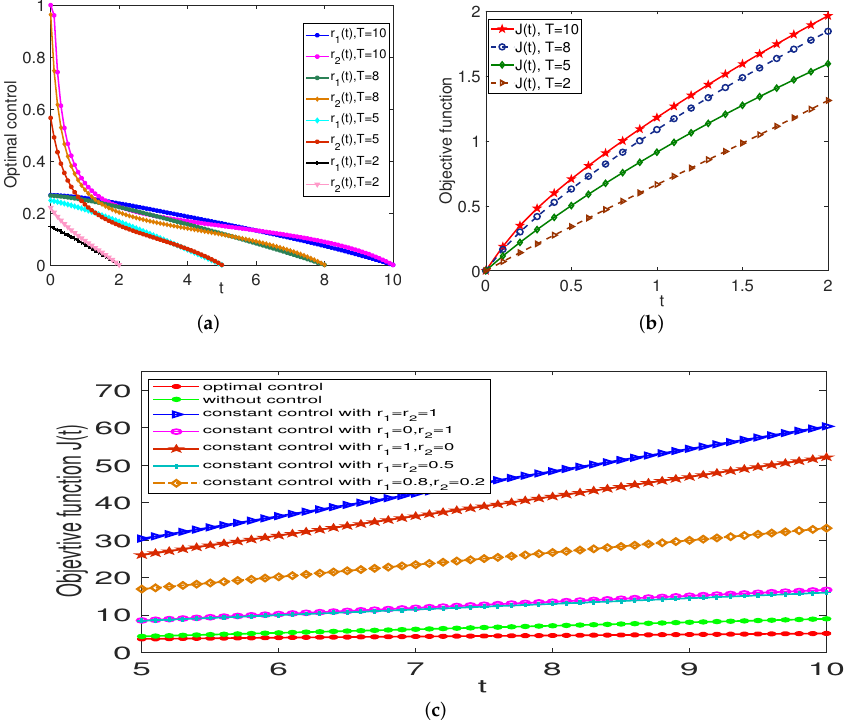
Figure 20. ( a ) The trajectories of optimal control r i ( t ) i = 1,2. ( b ) The objective function. J ( t ) with T = 2,5,8,10. ( c ) The consumption of J ( t ) under different r i ( t ) , i =